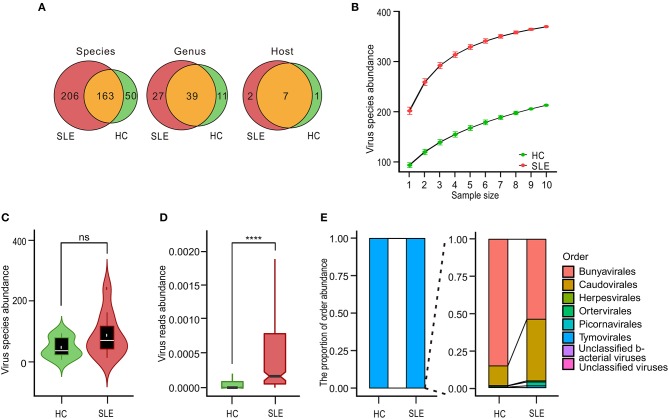
Variations in systemic lupus erythematosus (SLE)-associated peripheral blood mononuclear cell (PBMC) virome community. (A) Venn diagrams of virome species, genera, and host diversity between SLE patients and healthy controls (HCs). (B) Rarefaction plot showing the association of virus species diversity and sequencing depths for viral species in PBMCs of SLE and HC subjects. (C) Comparison of species diversity of virus communities in the disease state. White dots and black horizontal lines on integrated boxplots represent the mean and median values, respectively. ns, No significant difference. (D) Comparison of the abundance of virus communities in the disease state. Black horizontal lines on integrated boxplots represent the median values. ****P < 0.0001. (E) Relative sample composition and breakdown of viral metatranscriptomic sequences classified at order-level when compared with viral counterparts. Bar charts depicting taxonomic landscape of viral orders and overall relative proportions compared with virus taxa between HC and SLE samples.